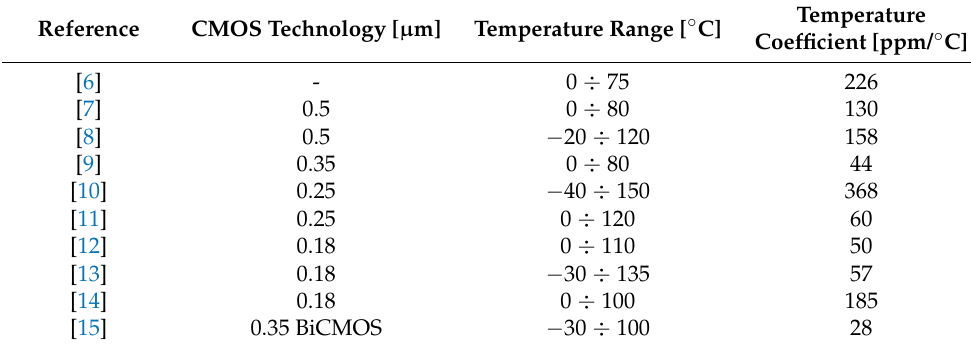
Table 2. Bandgap current reference temperature